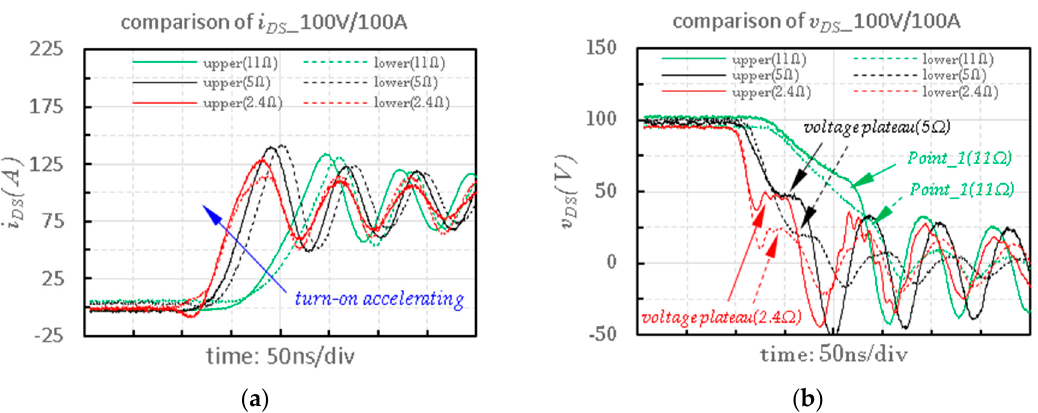
Figure 10. The comparison of turn-on transient waveforms of the module_D among various turn-on speeds under condition of a lower 𝑉 (cid:3005)(cid:3005) : ( a ) waveform of 𝑖 (cid:3005)(cid:3020) , ( b ) waveform of 𝑣 (cid:3005)(cid:3020) . From Figure 10, characteristics of voltage plateau in 𝑣 (cid:3005)(cid:3020) are observed for the cases of 𝑅 (cid:3034)(cid:3032)(cid:3051)(cid:3047) equals to 5 Ω and 2.4 Ω , in which the turn-on speed both are faster than 2.64 A/ns (this is turn-on speed of lower-side for the case of 𝑅 (cid:3034)(cid:3032)(cid:3051)(cid:3047) equals to 5 Ω .), the difference in value of the drain-source voltage plateau between upper-side and lower-side is almost same regardless of the rise of the turn- on speed, which is about 25